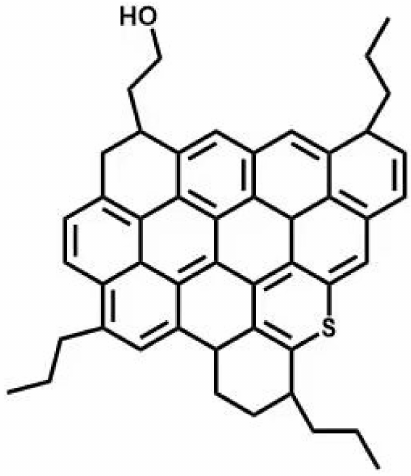
Figure 5. The deduced chemical structure of asphaltene